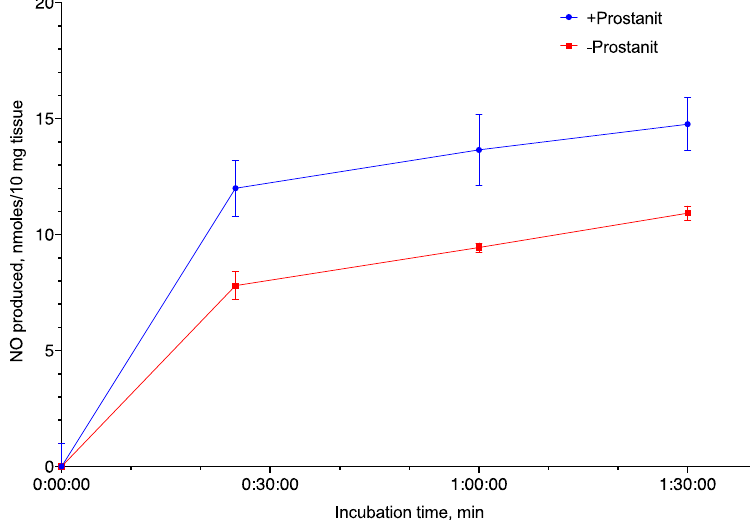
Figure 2. Nitric oxide (NO) generation from Prostanit by rat aorta fragments (10 mg). Prostanit concentration = 156 µM, NO quantification using the Griess method, mean ± SD ( N = 3 experiments); the differences at all time points except 0 min are significant (ANOVA with Tukey’s post-test, p < 0.05).